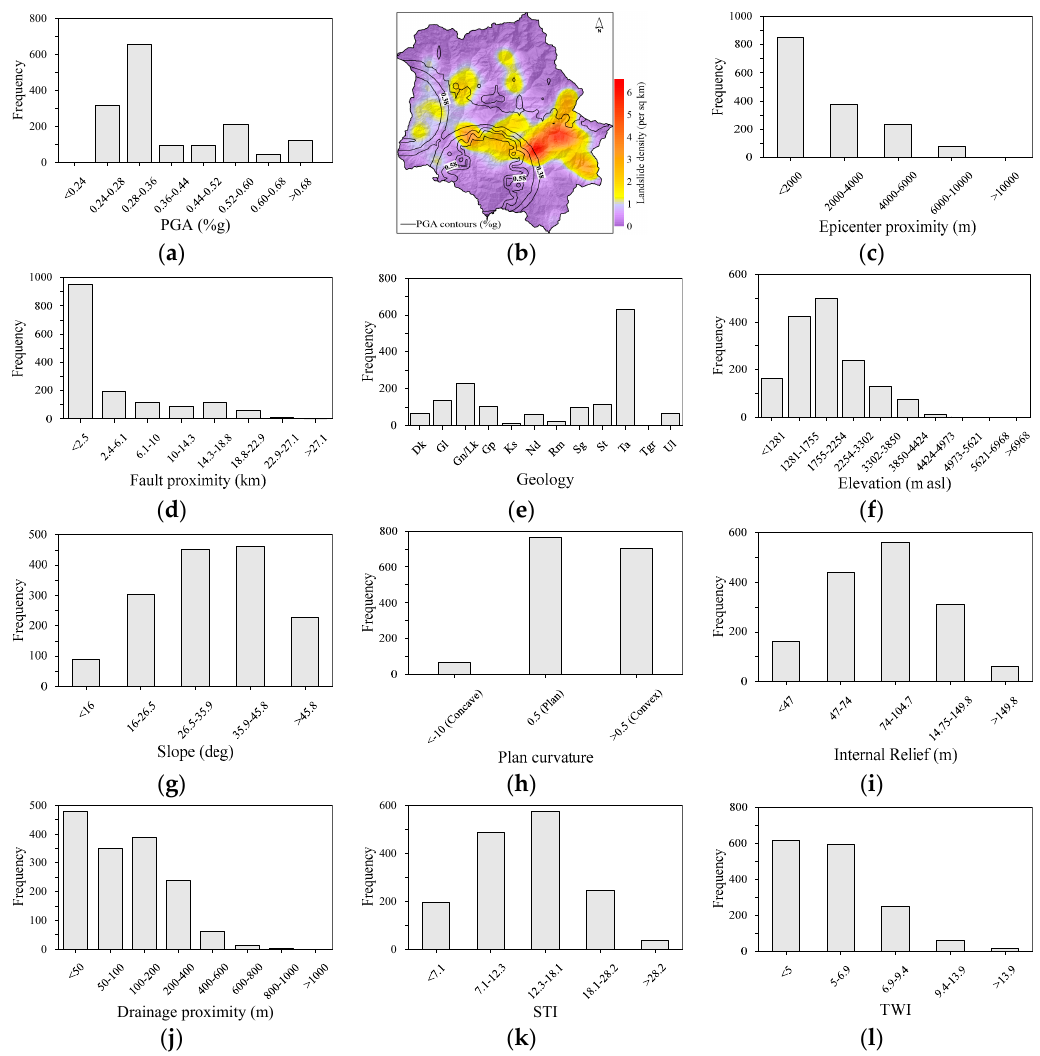
Figure 10. Frequency of landslides and area of their influence: ( a ) PGA; ( b ) overlay between PGA and landslide density; ( c ) epicenter proximity; ( d ) fault proximity; ( e ) geology; ( f ) elevation; ( g ) slope; ( h ) plan curvature; ( i ) internal relief; ( j ) drainage proximity; ( k ) STI; ( l ) TWI.